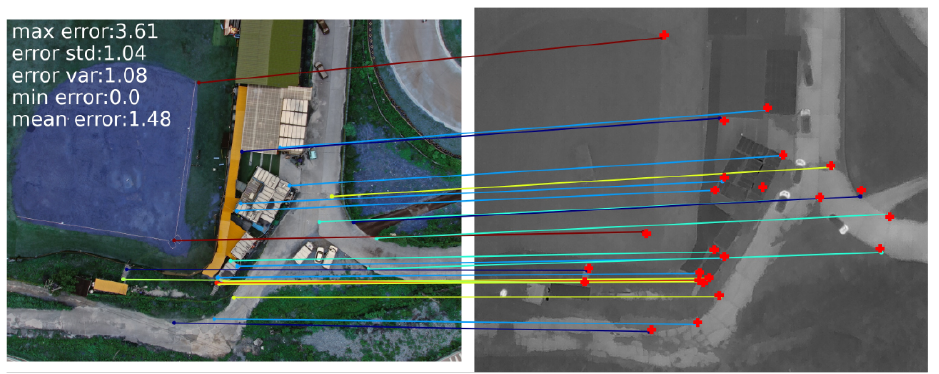
Figure 10. The different color lines reflect the relative magnitude of the re-projection error, with the reddest approximately approaching the maximum error and the bluer closer to the minimum error. Simple statistics of the error for this image are annotated in the top left.